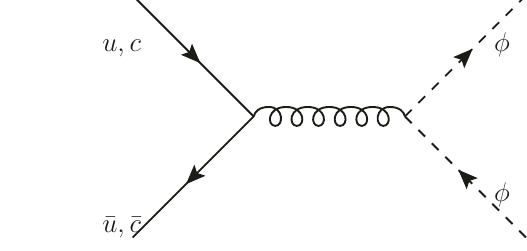
Figure 21 . Gluon fusion dijet processes (cid:27)